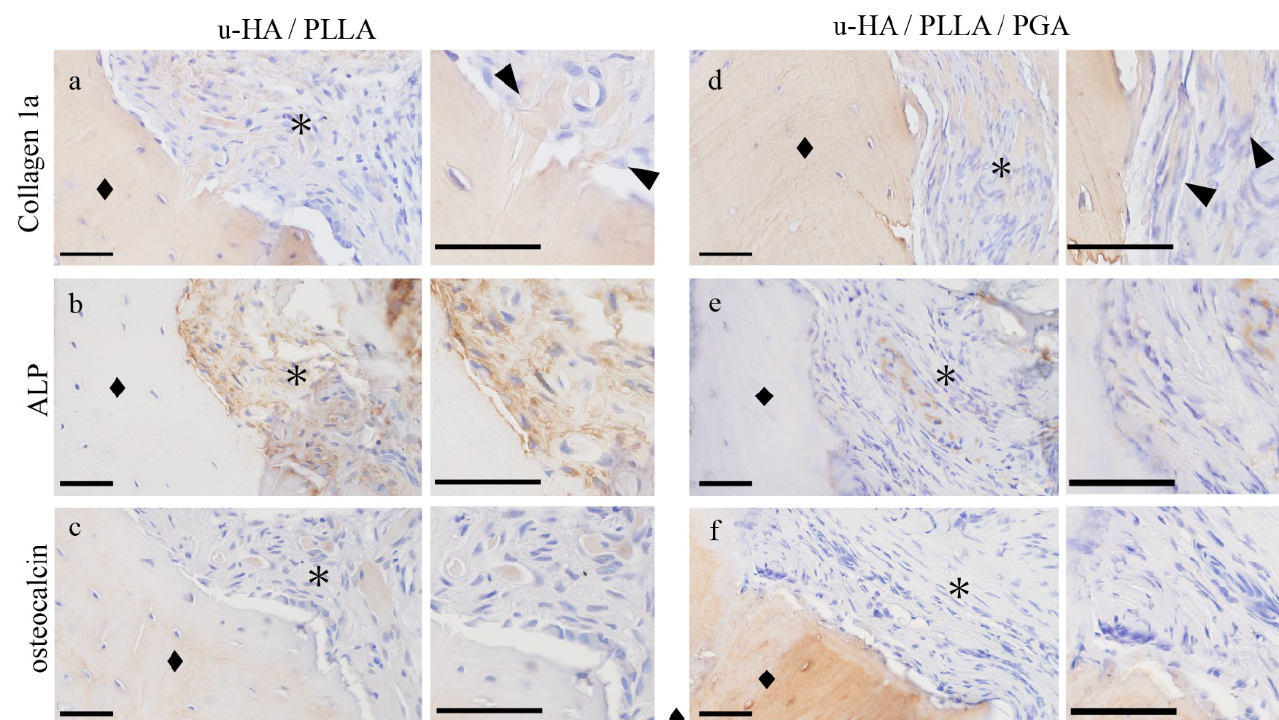
Figure 5. The immunohistochemical characteristics of the connective tissue samples. ( a , d ) Collagen 1a, ( b , e ) ALP, and ( c , f ) osteocalcin staining. ( a – c ) u-HA/PLLA group: The fibers are seen as bundles penetrating the bone perpendicular to it. Fibers are positive for collagen 1a (( a ) ▲ ). ALP and osteocalcin expression in the connective tissue. ( d – f ) u-HA/PLLA/PGA group: Collagen fibers run parallel to the bone (( d ) ▲ ). Bone ( ) and connective tissue (*). Bar: 50 μm.